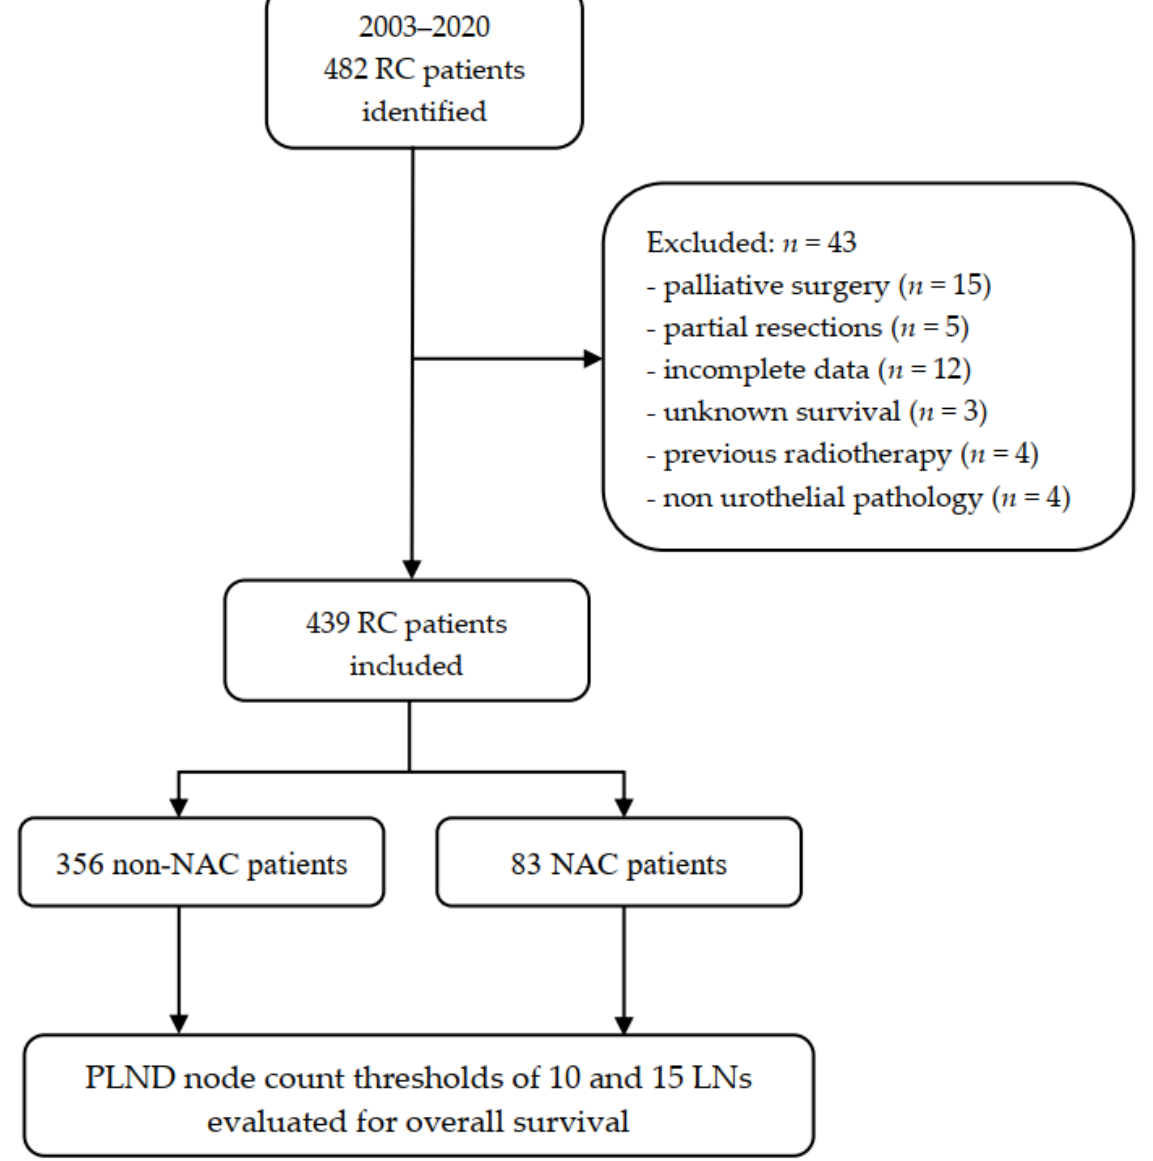
Figure 1. Flowchart of the study. NAC: neoadjuvant chemotherapy; RC: radical cystectomy; PLND: pelvic lymph node dissection.